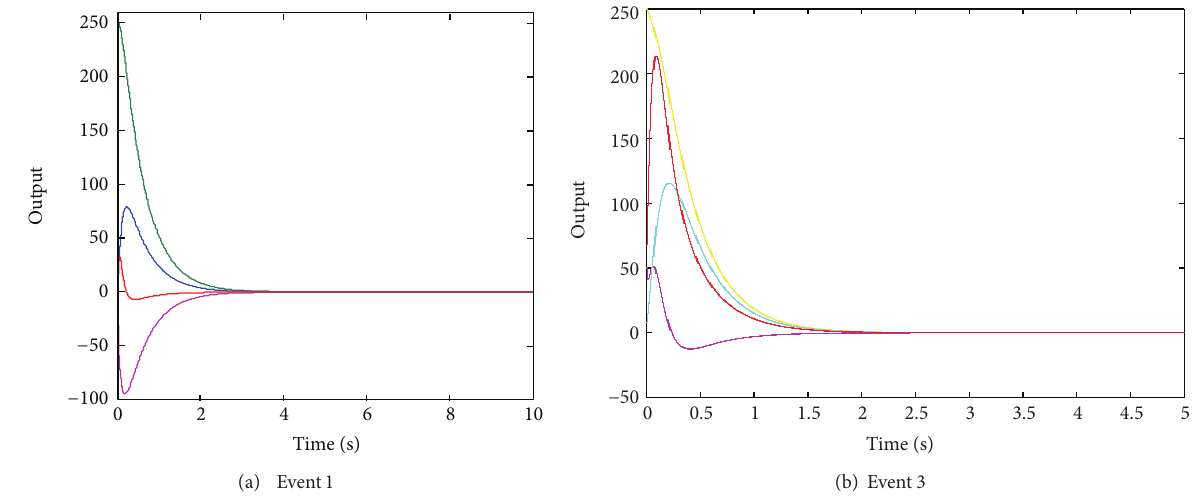
Figure 4: Output of the closed-loop NCS with data packet dropout and actuator fault.